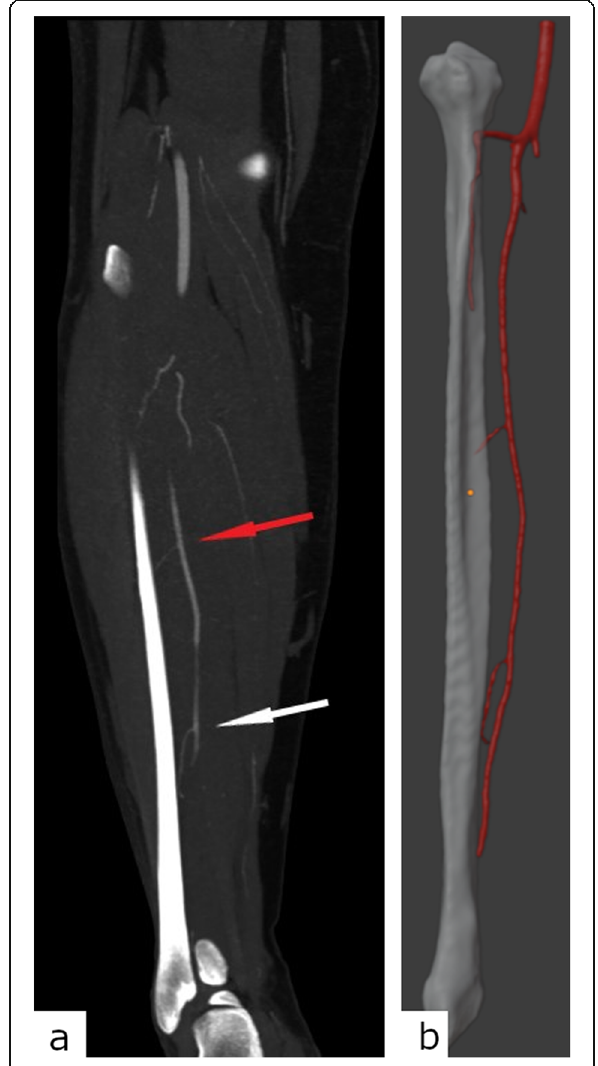
Fig. 1 Visualisation of the peroneal artery perforators for the appropriate fibula orientation in space. a Coronal maximum intensity projection thick reconstructions of the right lower leg computed tomography angiography shows a good delineation of the proximal (red arrow) and distal (white arrow) peroneal artery perforators.